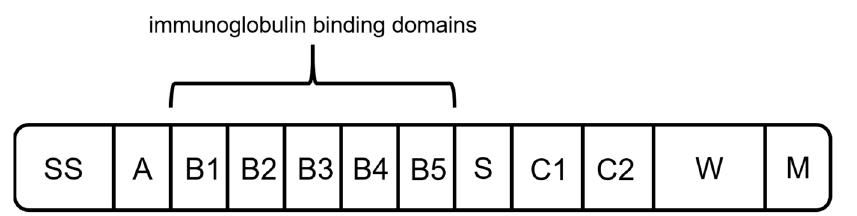
Figure 6. Schematic structure of protein L. It is composed of a hydrophobic signal sequence (SS), the NH 2 terminal domain (A), repeated immunoglobulin-binding domains (B1–B5), a spacer region (S), C1 and C2 with unknown function, and the cell-wall anchoring domain [71] .